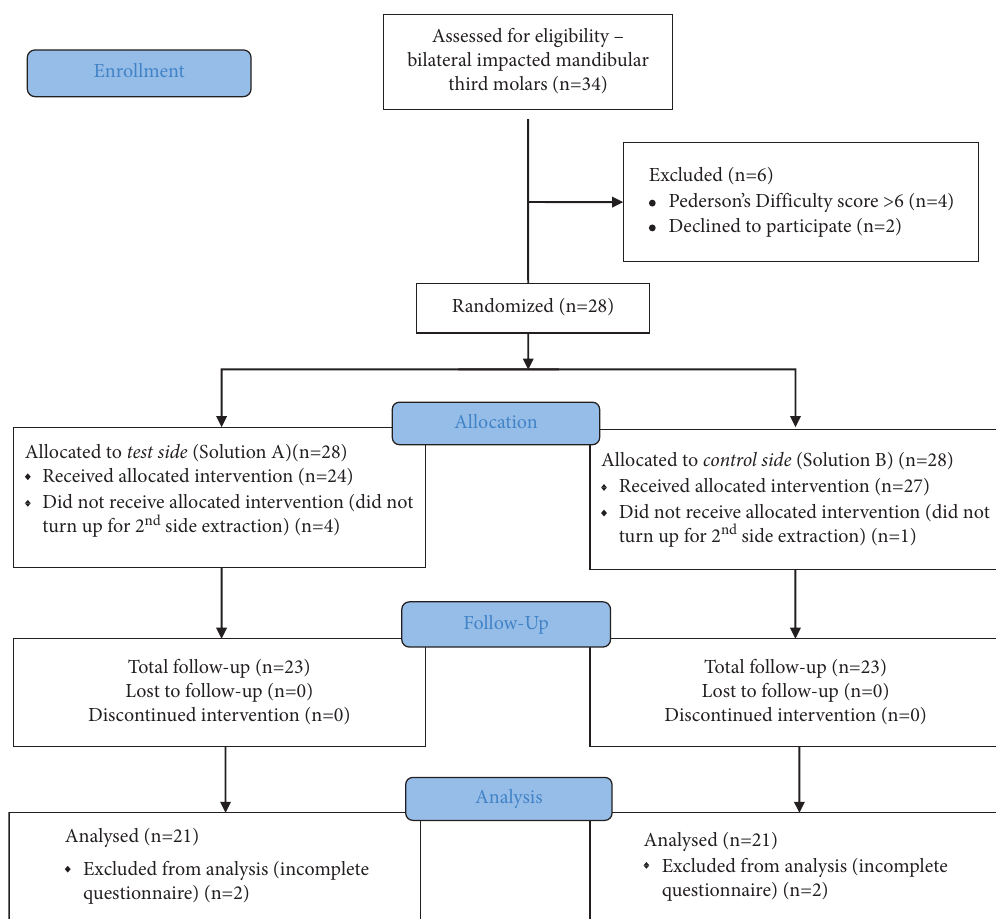
Figure 1: CONSORT flowchart showing the progress of participants included in the randomized controlled trial. Table 1: Comparison of the mean pain scores between test and control interventions. Pain score